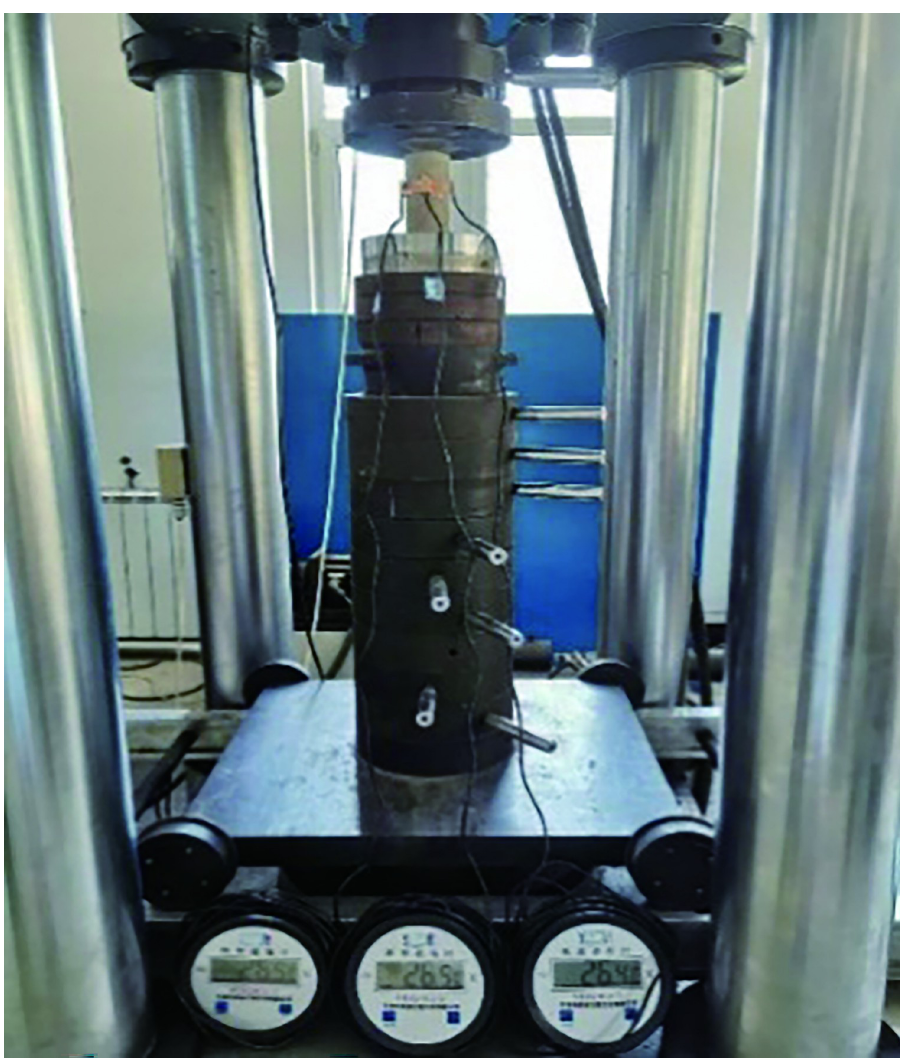
Fig 15. Test installation.